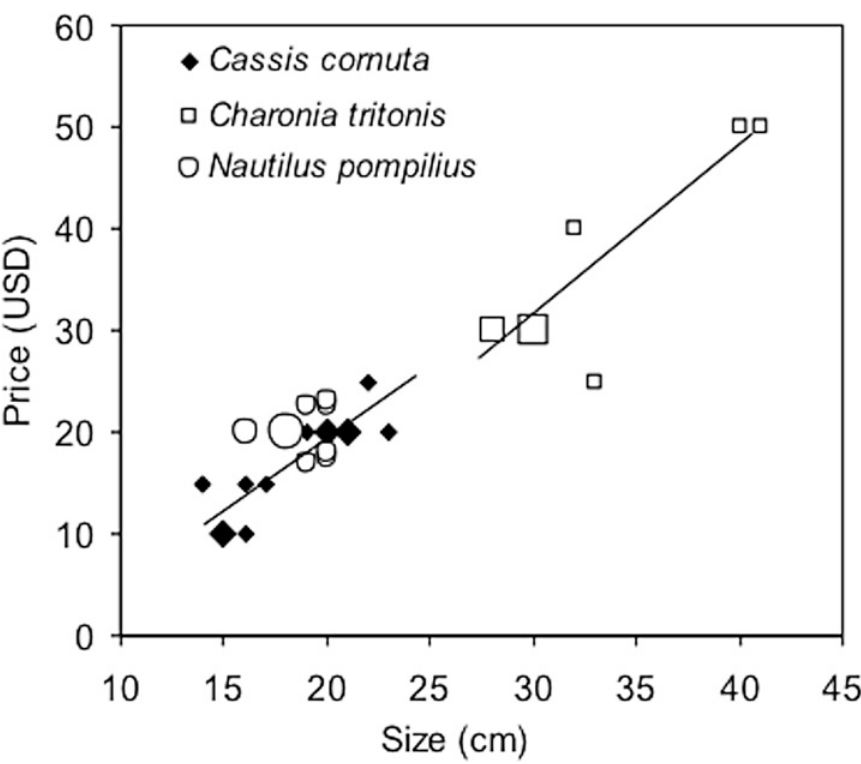
Fig 4. Price-size relationships for shells in trade. Prices of horned helmet Cassis cornuta , Triton ’ s trumpet Charonia tritonis and chambered nautilus Nautilus pompilius shells in relation to size, in Pangandaran, Indonesia, June 2013. Prices were given in Indonesian rupiah and are here converted to the US dollar at an exchange rate of 10,000 rupiah to the dollar. Small-sized symbols indicate single shells, medium-sized indicate two shells and large-sized symbols three shells; regression lines are for horned helmet and Triton ’ s trumpet only. doi:10.1371/journal.pone.0140593.g004 each cm increase in size. Prices at Pasir Putih appeared to be similar. Giant clam were sold for around USD 25.00, with lower prices for single shells and higher prices for complete double- shelled specimens. False trumpet was the most expensive shell ranging between USD 50.00 and USD 70.00. Details of prices and sizes are presented in Fig 4 and Table 3. Based on average prices and numbers observed, the retail value of the shells highlighted in Table 1 in Pangandaran totals between USD 3,500 – 5,200 (January) or USD 3,200 – 4,500 (June) and that of Pasir Putih between USD 3,100 – 4,800. This excludes the smaller protected species that are traded in larger volumes but at lower prices per individual shells (with asking prices of less than USD 0.50 these may add a few hundred dollars to the total, at most). In monetary Table 3. Prices of shells. Prices (in USD) of large marine mollusc shells observed in trade in Pangandaran and Pasir Putih, Java. For species where there is a price-size relationship the shell size for the lowest and highest prices is included. Species Mean ± s.d.